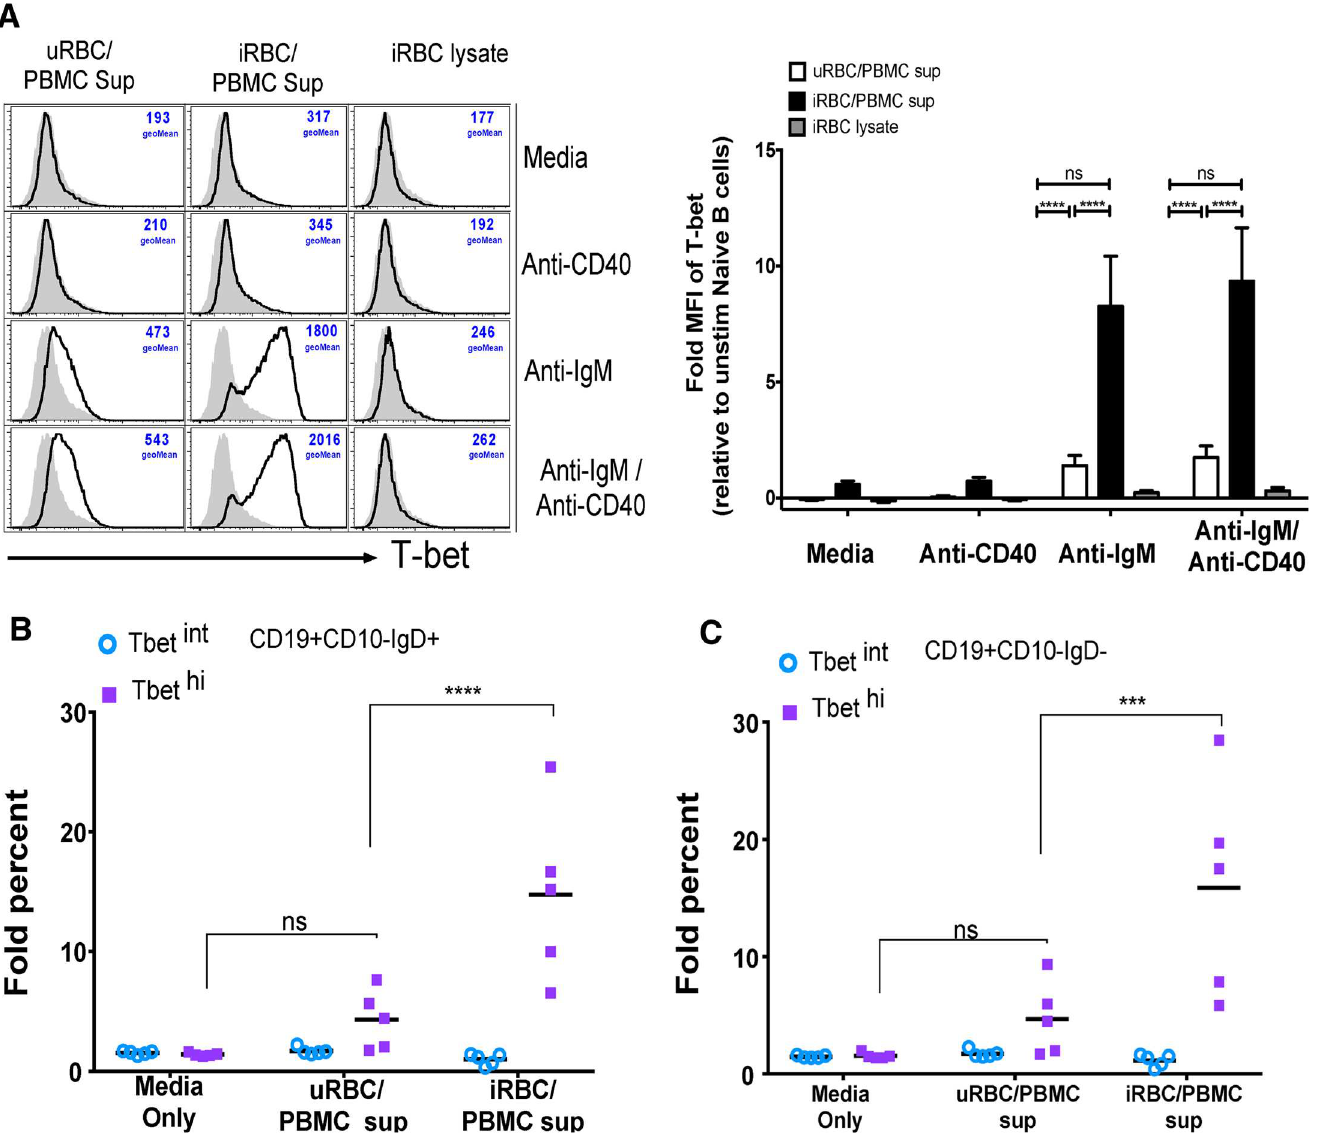
Fig 10. Supernatants of PBMCs stimulated with P . falciparum -infected RBCs plus BCR cross-linking drive T-bet expression in B cells. ( A-C ) PBMCs of healthyU.S. adults (n = 5) were stimulatedin vitro with P . falciparum -infected red blood cell (iRBC) lysate or uninfectedred blood cell (uRBC) lysate for 3 days. The resultingsupernatants or the iRBC lysate alone were transferred to PBMCs from the same U.S. adults (n = 5) in the presenceof media alone,anti-IgM, anti-CD40, or both, followedby stainingfor T-bet, CD10, CD19and IgD. ( A ) Fold changein T-bet MFI in stimulatedna ï veB cells relative to unstimulated na ï veB cells (left, representative histograms). Fold change in percentage of T-bet intermediate (T-bet int ) and T-bet high (T-bet hi ) ( B ) na ï veB cells and ( C ) memory B cells after BCR cross-linking with anti-IgM/G/A in the presenceof media alone, uRBC/PBMC supernatant or iRBC/ PBMC supernatant, relative to unstimulated cells. Horizontalbars and whiskers represent means or medianand SE. p values were determinedby paired Student’s t test with Bonferroni adjustmentswhere appropriate. **** P < 0.0001, *** P < 0.001, ** P < 0.01, * P < 0.05,ns = not significant.